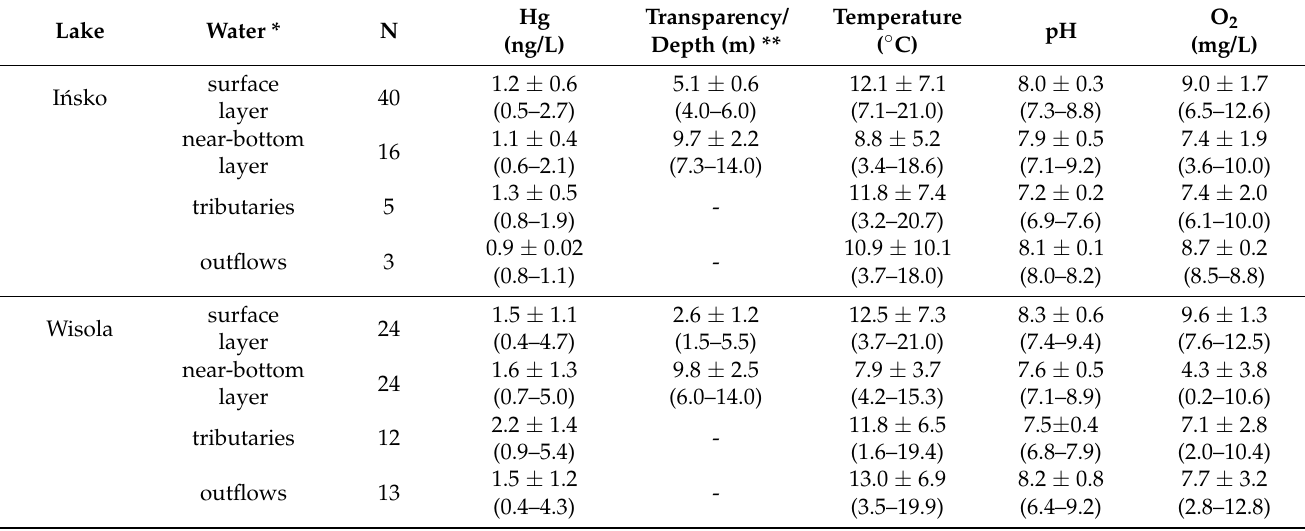
Table 2. Mercury concentration and other parameters of water from lakes I´nsko and Wisola (mean ±